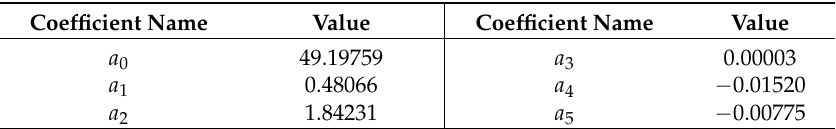
Table 2. Kolmogorov-Gabor ( K–G ) polynomial coefficients.